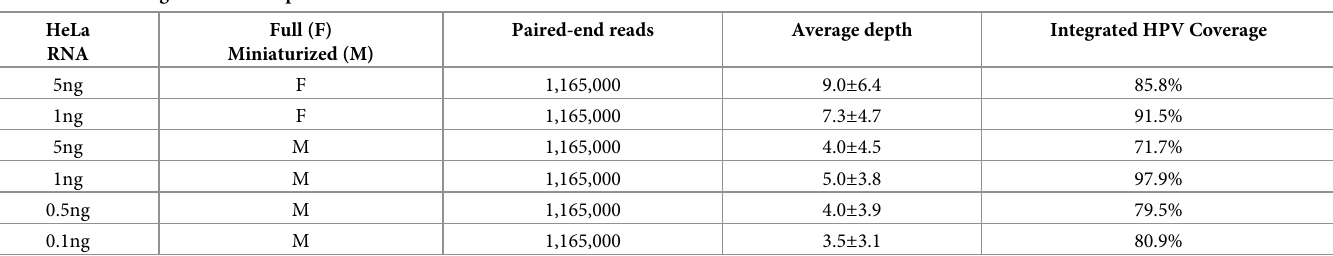
Table 1. HPV coverage in HeLa samples.